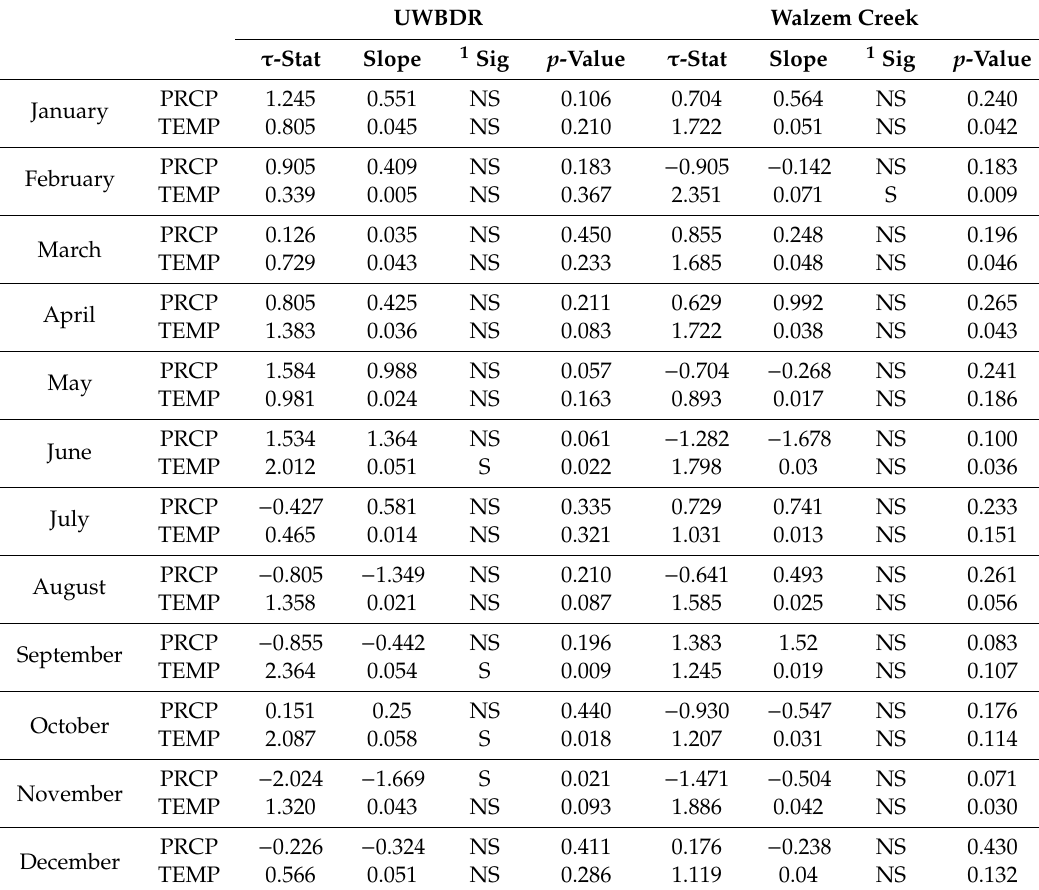
Table 5. Summary of significance test and trend analysis for monthly precipitation and temperature in the UWBDR and Walzem Creek watersheds.